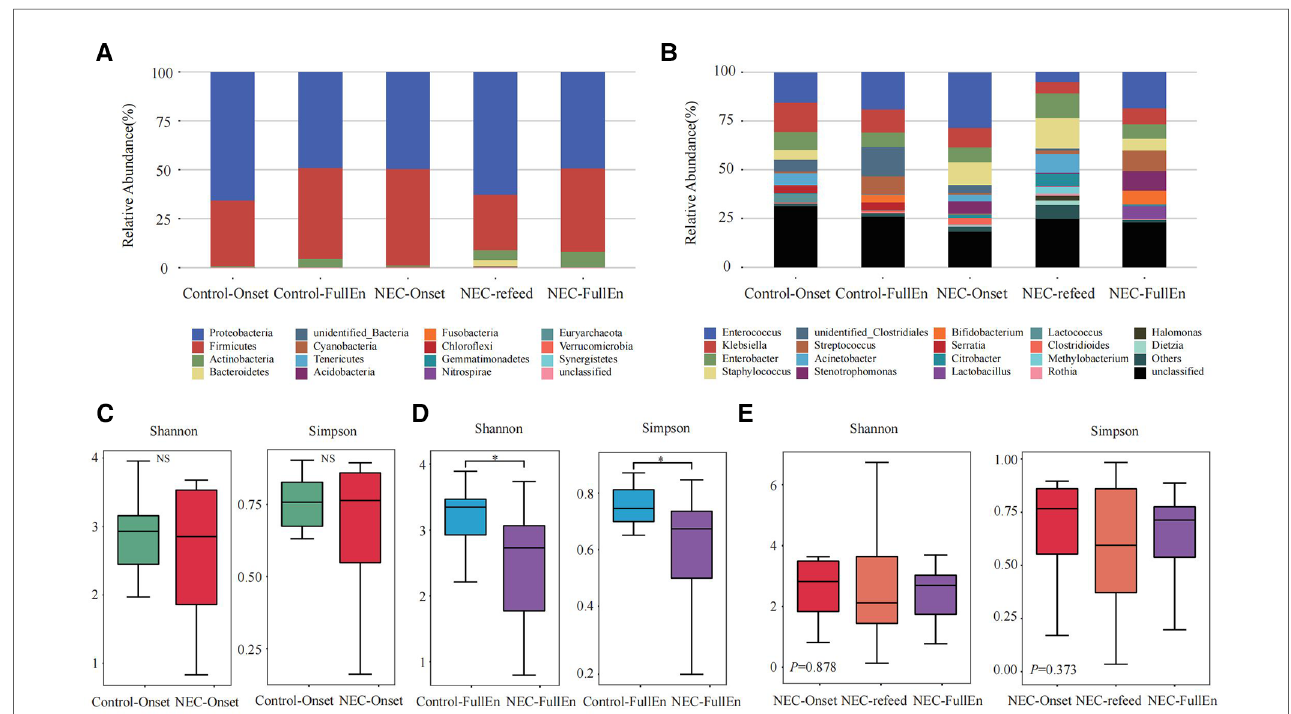
FIGURE 2 Taxonomic composition analysis and alpha diversity analysis. ( A,B ) Taxonomic composition analysis. ( A ) The top 10 at the phylum level between each group. ( B ) The top 20 at the genus level between each group. ( C – E ) Alpha diversity analysis. ( C ) Alpha diversity analysis between the NEC_Onset group and the Control_Onset group. ( D ) Alpha diversity analysis between the NEC_FullEn group and the Control_FullEn group. ( E ) Alpha diversity analysis between the three